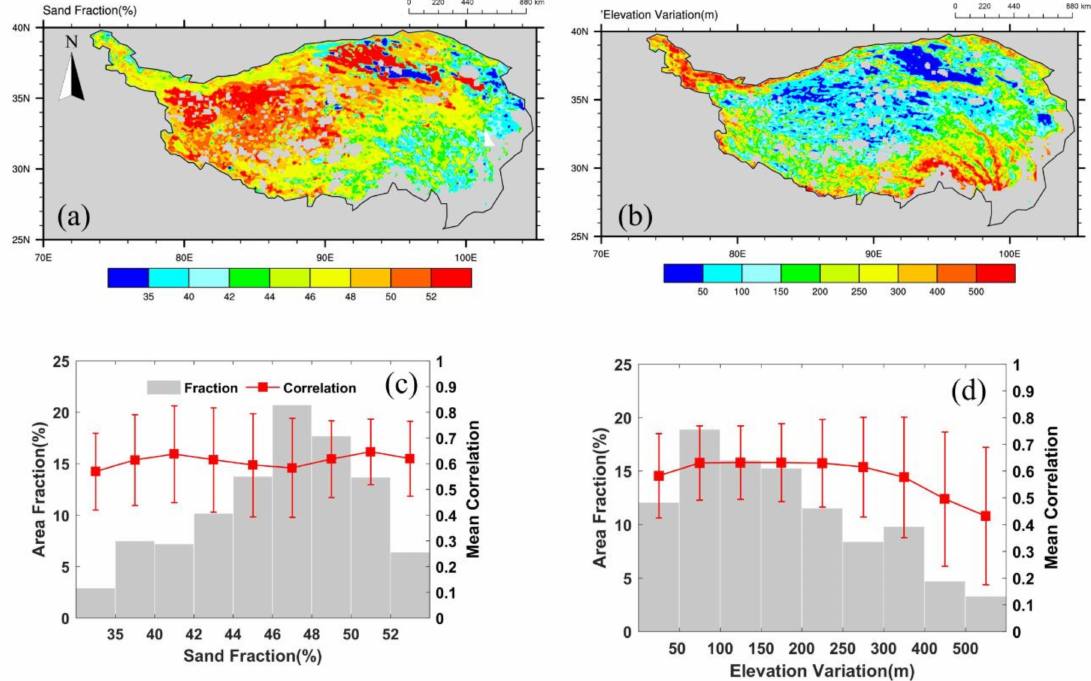
Figure 7. Spatial distributions (top row) of: ( a ) soil sand fraction (%); and ( b ) the elevation variations (m) over the Tibetan Plateau. Average correlations between the SMAP L3_SM_P_E product and the CLM simulations across: ( c ) different soil sand fractions; and ( d ) different elevation variations. The area fractions represented by each bin are shown as gray bars and the average correlations are shown as red lines, with error bars representing standard deviation of correlations in each